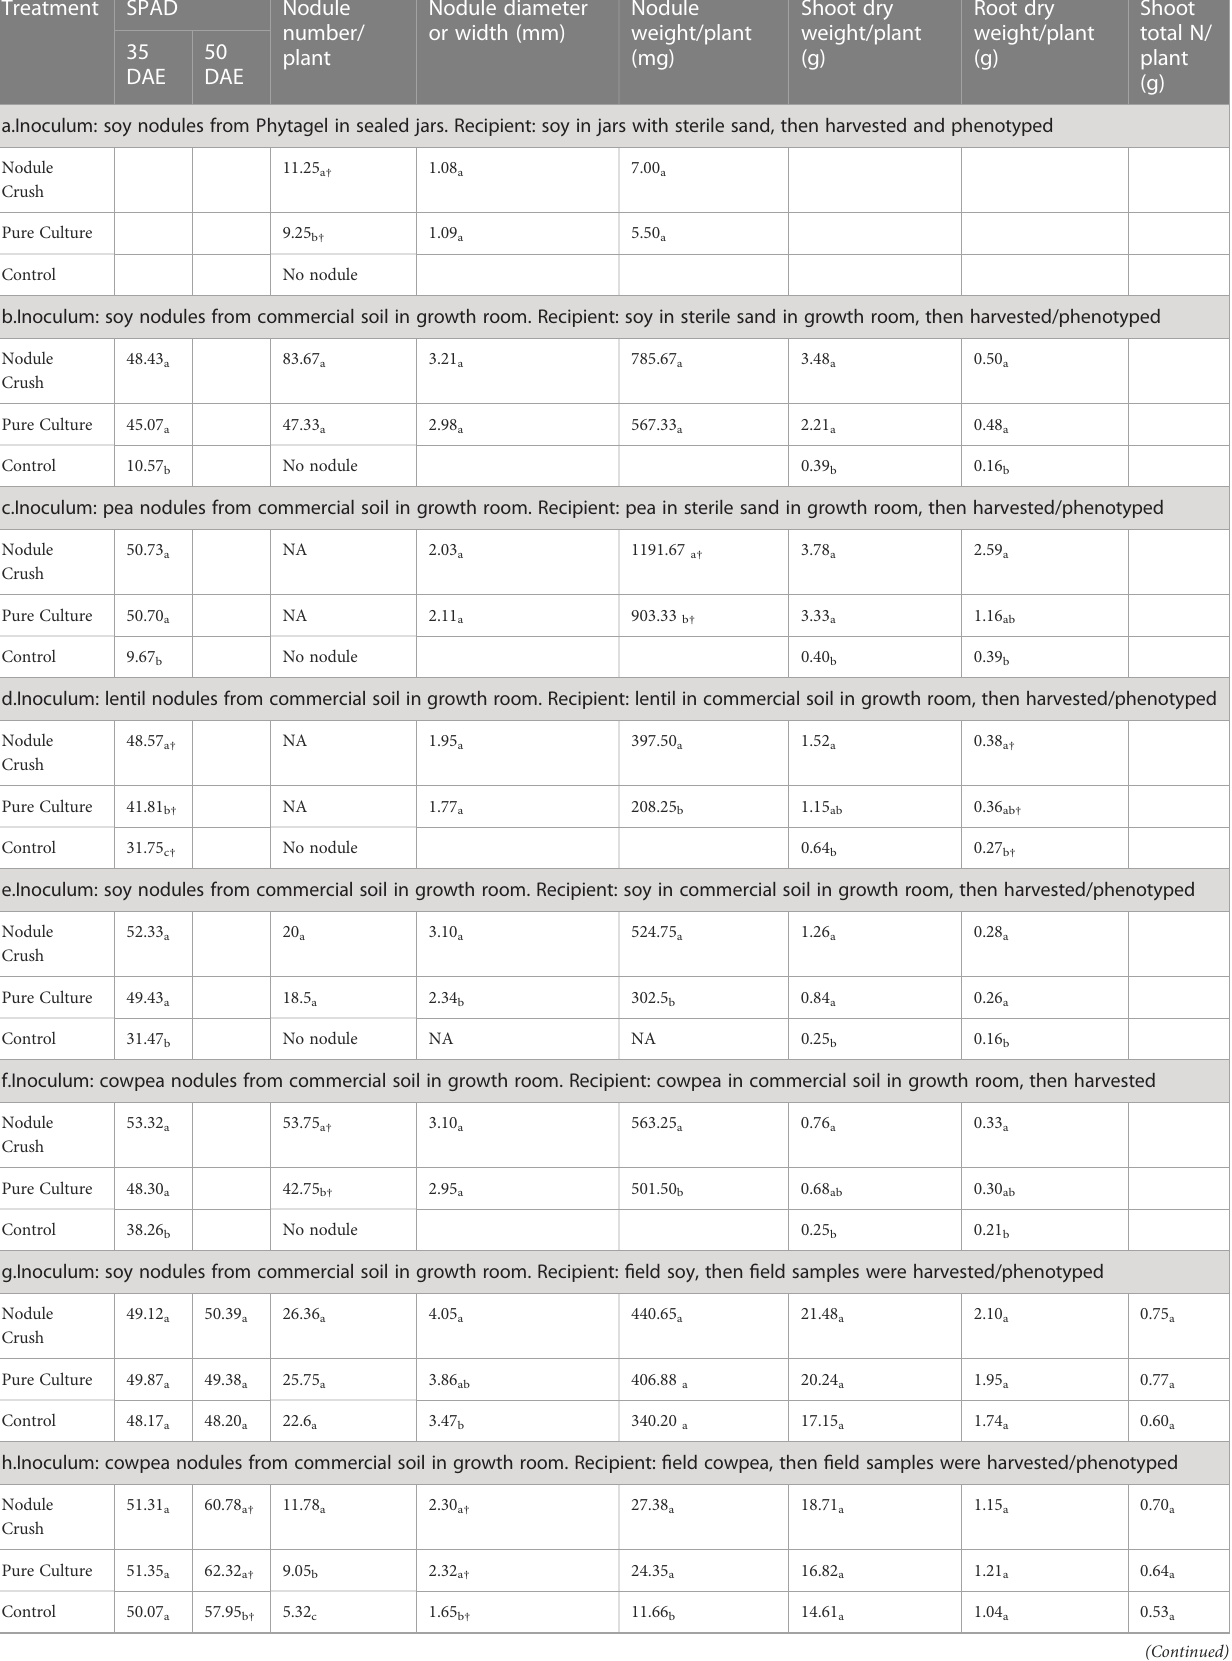
Nodule diameter number/ or width (mm) plant